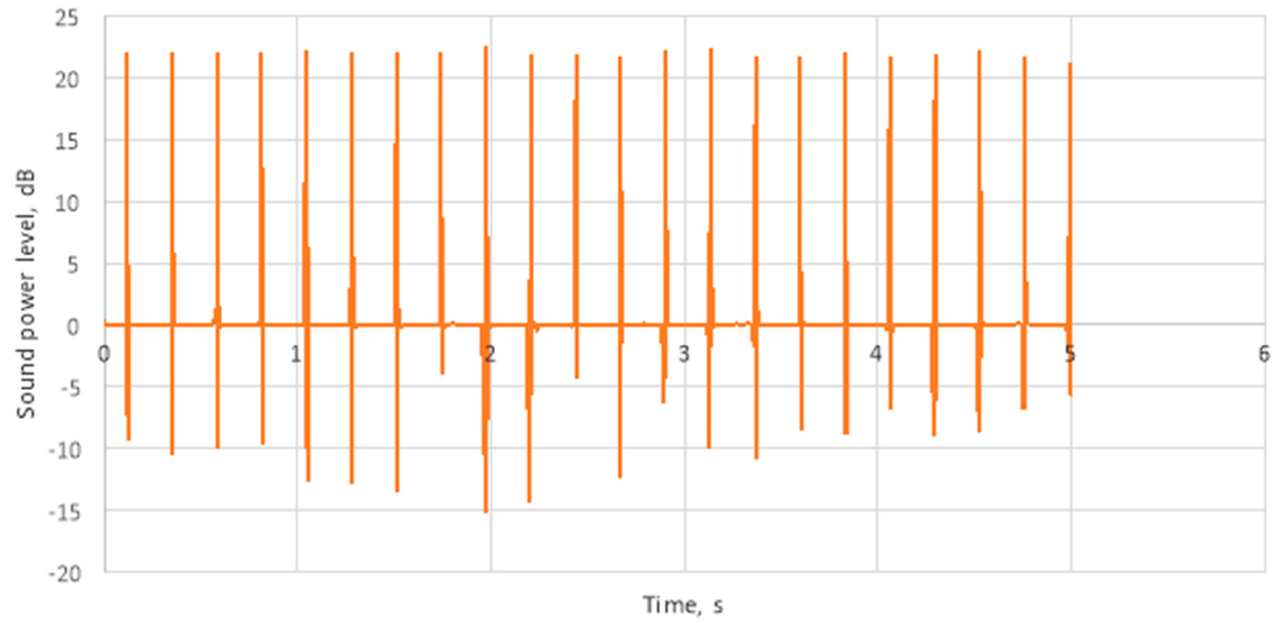
Figure 13. Calculated sound power level values of the 69th wheelset.